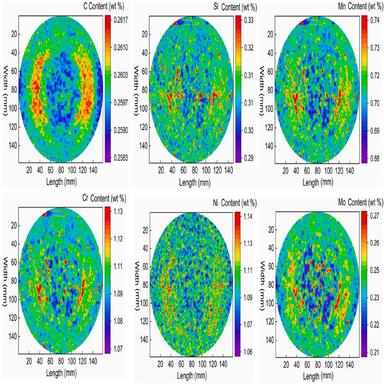
Corrected 2-D content distribution of C, Si, Mn, Cr, Ni, Mo element of row mapping: in-row corrected by second-order polynomial and inter-row corrected by total average.